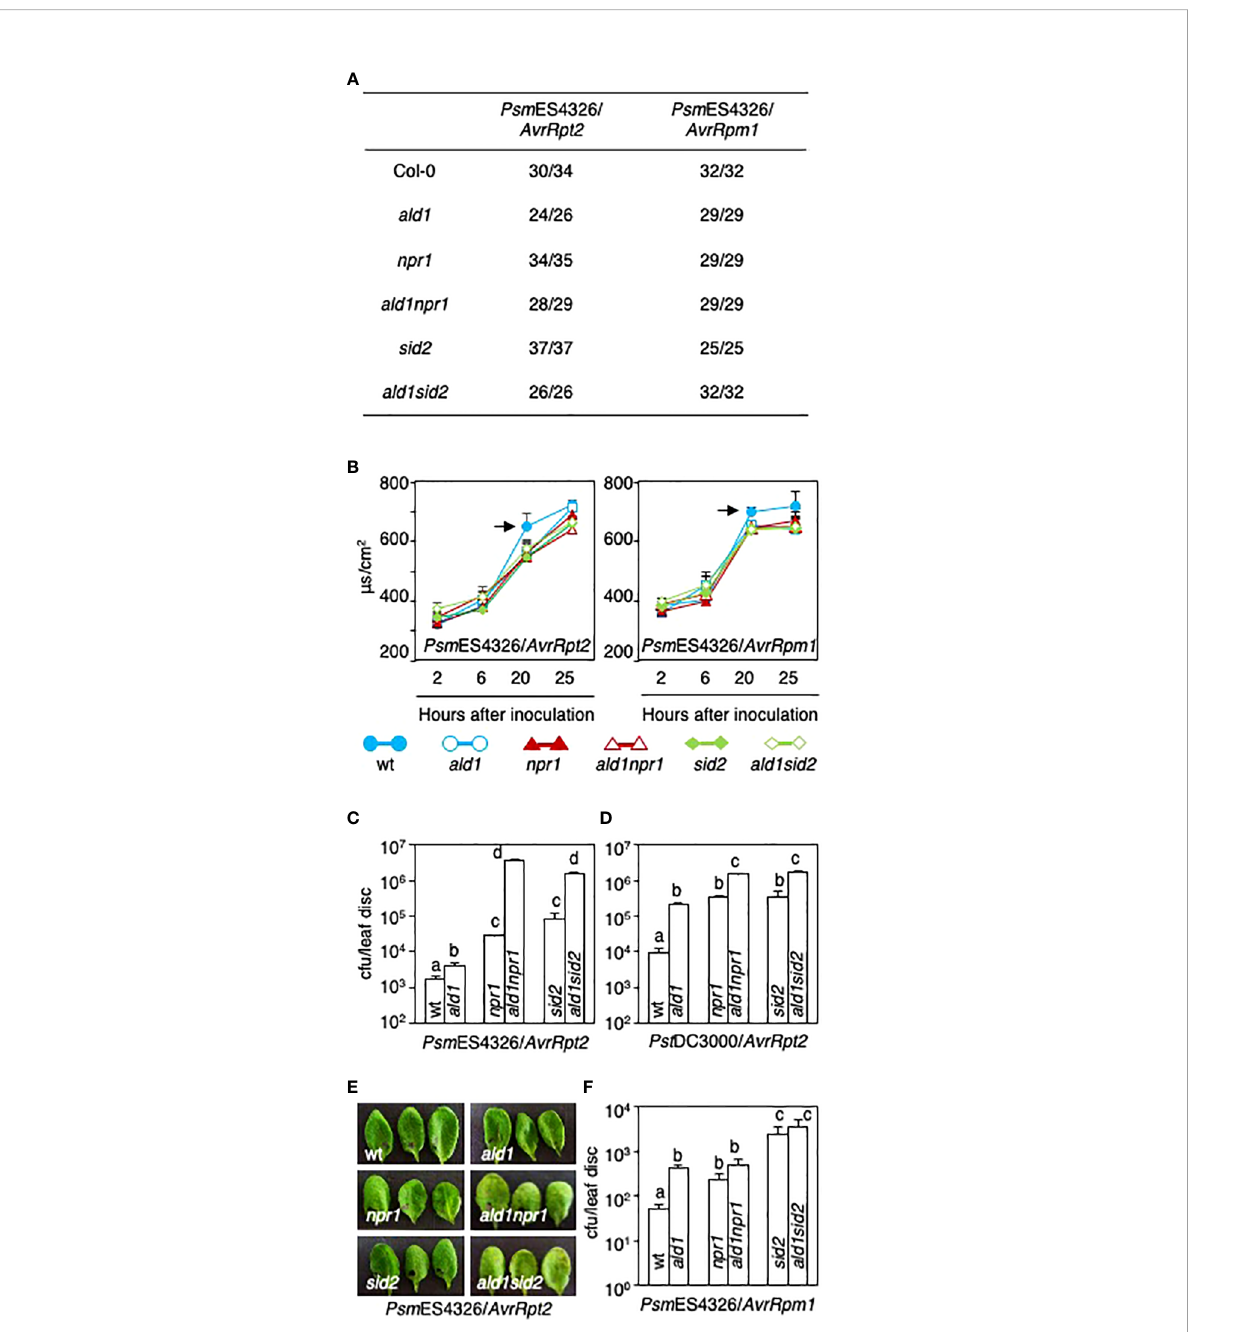
FIGURE 3 Both ald1npr1 and ald1sid2 mutants show susceptibility in response to avirulent derivatives of Pseudomonas carrying AvrRpt2 , but not AvrRpm1 . (A) The number of leaves exhibiting HR out of the number of leaves infected with two different avirulent derivatives, Psm ES4326/ AvrRpt2 or Psm ES4326/ AvrRpm1 (OD 600 = 0.01). (B) Electrolyte leakage from leaves of Arabidopsis after infection with Psm ES4326/ AvrRpt2 (left panel) or Psm ES4326/ AvrRpm1 (right panel) (OD 600 = 0.05). Data represent the averages with standard deviations (n = 4). Arrows indicate statistically signi fi cant differences between WT and mutants ( p < 0.01, two-tailed Student ’ s t-test). The experiments were repeated twice with the same results. (C, D) Pathogen growth in leaves of ald1npr1 and ald1sid2 mutants after Psm ES4326/ AvrRpt2 infection (C) and Pst DC3000/ AvrRpt2 infection (OD = 0.0001) (D) . (E) Symptom development in the leaves of ald1npr1 and ald1sid2 mutants after Psm ES4326/ AvrRpt2 infection (OD 600 = 0.0001). The photos were taken on day 3 after inoculation. (F) Growth of an avirulent derivative, Psm ES4326/ AvrRpm1 , in leaves of Arabidopsis 3 days after inoculation (OD 600 = 0.0001). Data (C, D, F) represent the averages with standard errors (n = 8, or 12). Different letters indicate statistically signi fi cant differences ( p < 0.01, one-way ANOVA). The experiments were repeated more than three times with the same